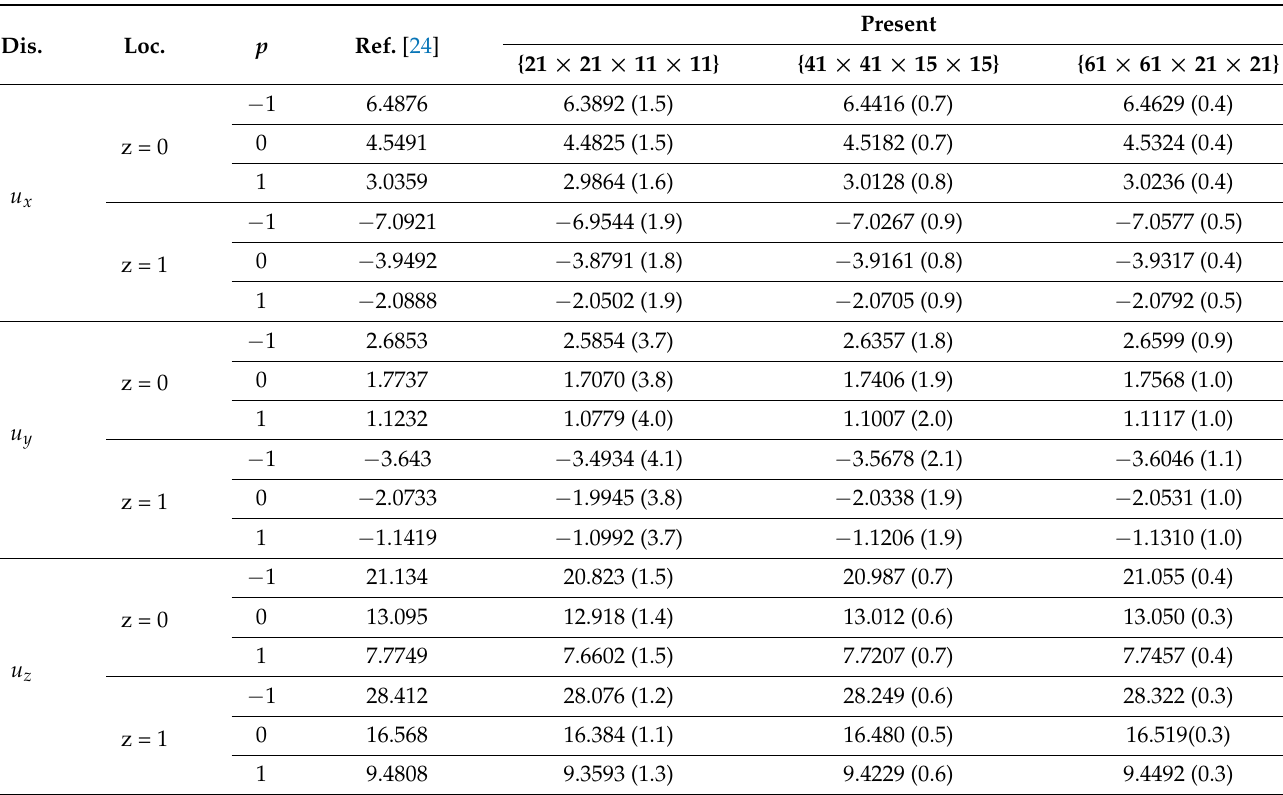
Table 4. The displacement components for three values of material parameter p , for Example 1, for boundary conditions SSSS obtained using different grid sizes. Dis.